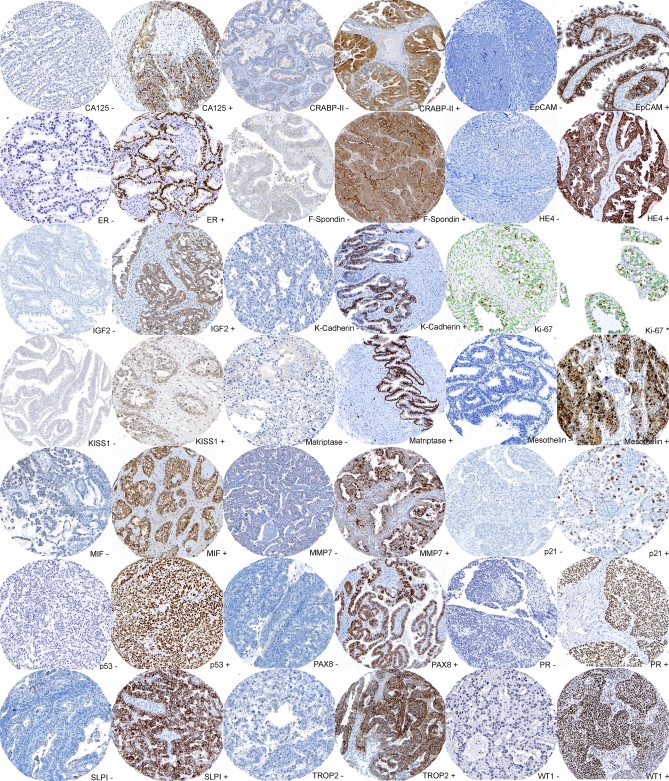
Representative ImmunostainsPaired positive and negative examples for each biomarker.